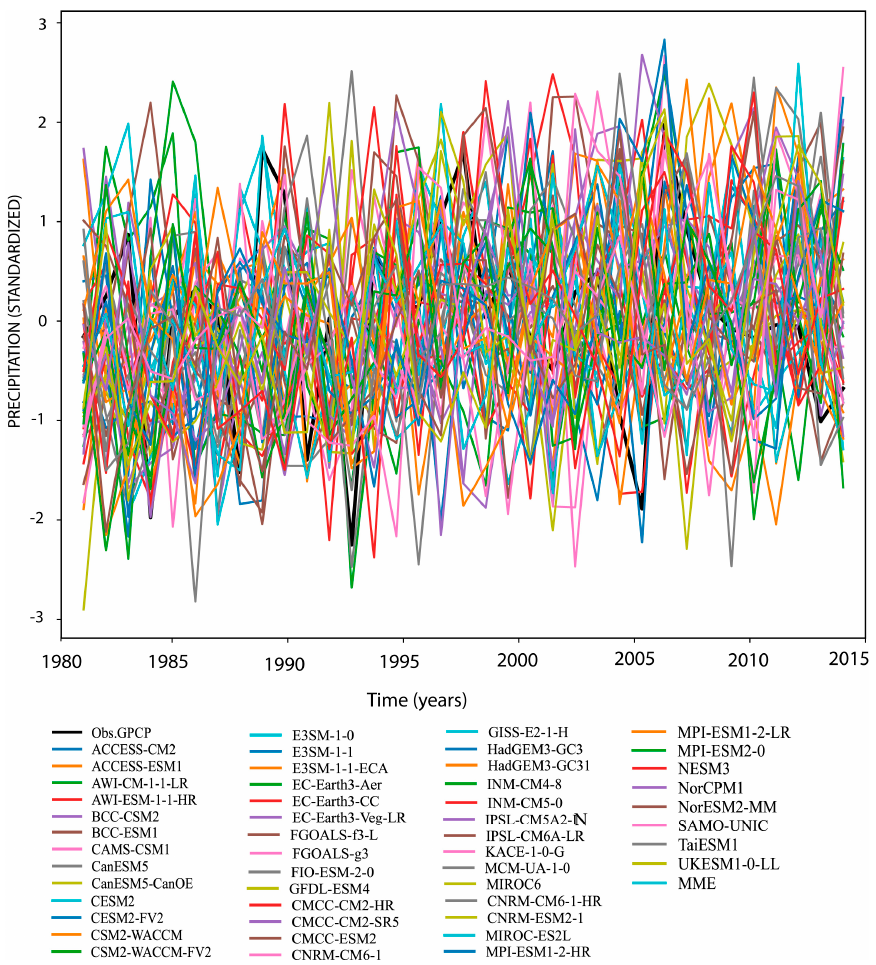
Figure 5. Interannual variations of observation (i.e., GPCP, black line) in CMIP6 MME- and 49 CMIP6-simulated precipitation anomalies during 1980–2014 across Africa and the Arabian Peninsula. Anomalies were calculated using the mean over the period.